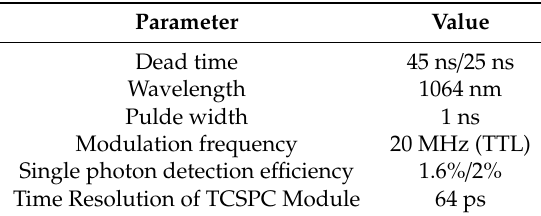
Table 1. Main Parameters of the LIDAR System.